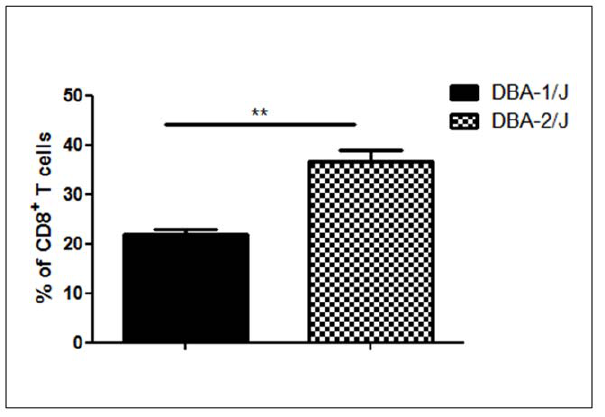
Figure 9. Reduced percentage of Ror c t + T cells during collagen immunization of DBA-2/J strain. The percentage of splenic or lymph node expressing ROR c t T cells of DBA-1/J and DBA-2/J mice during immunization with type II collagen was evaluated by flow cytometry. The control mice were immunized just with complete Freund’s adjuvant without any collagen. Data from three independent experiments are shown. The results are presented as means standard error of mean (SEM). The differences were evaluated by a one-way ANOVA followed by Bonferroni’s test. *P , 0.05 was considered statistically significant in DBA-2/J mice strain when compared to DBA- 1/J after CIA induction.